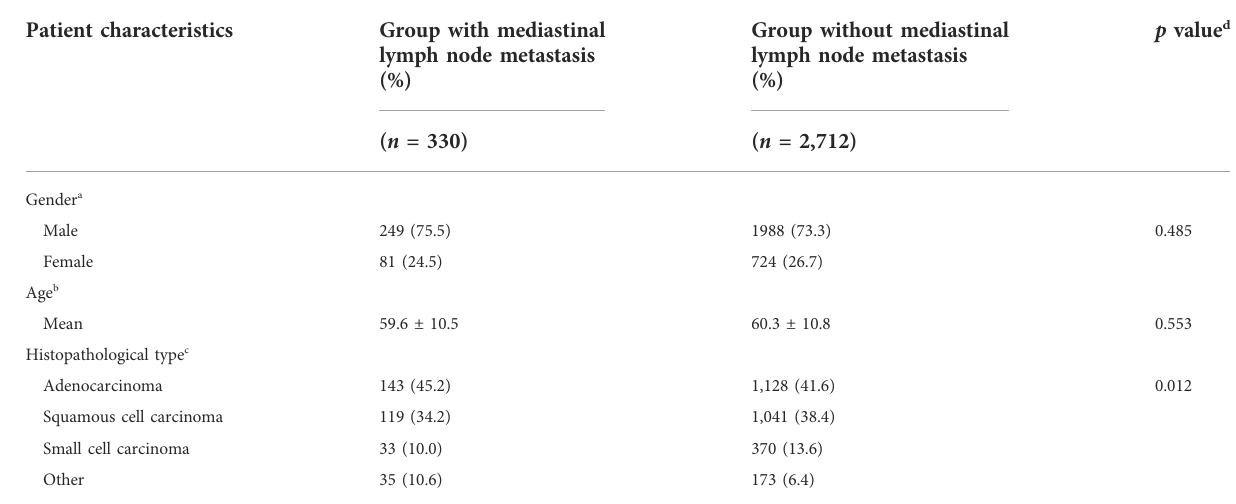
(NSE), cytokeratin fragment 19 (CYFRA 21-1), CA-125, CA-153,